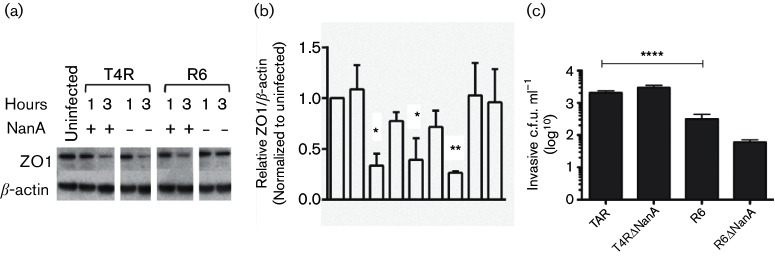
Effect of bacteria ± NanA on host barrier cells. (a) Top panel: ZO-1 expression in hBMECs after infection with T4R, T4R ΔnanA, R6 and R6 ΔnanA strains for 1 and 3 h. Data presented as mean±sem of three independent experiments. (b) quantitation of panel (a). Expression levels were normalized to uninfected control. *P<0.05, **P<0.01. (c) hBMECs were infected with the indicated pneumococcal strains and bacterial invasion was assessed by intracellular c.f.u. at 2 h. Mean±sem of ≥three independent experiments. ****P=0.0001.